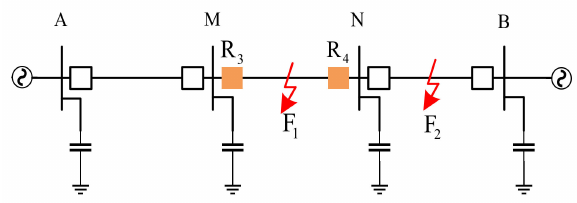
Figure 9. Schematic diagram of a 500 kV AC transmission system.